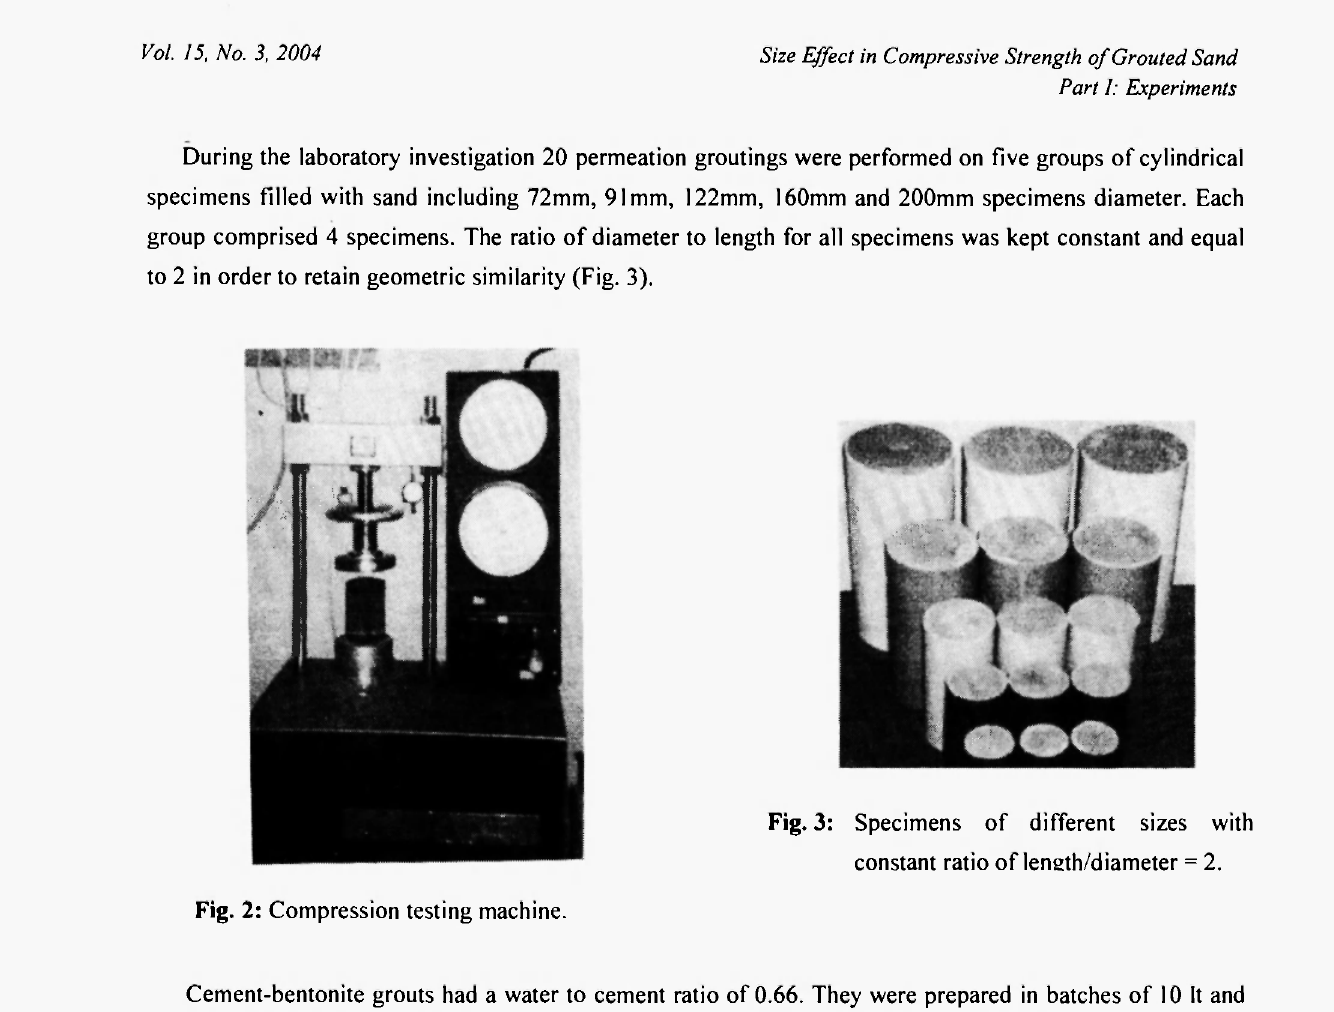
Fig. 3: Specimens of different sizes with constant ratio of leneth/diameter =